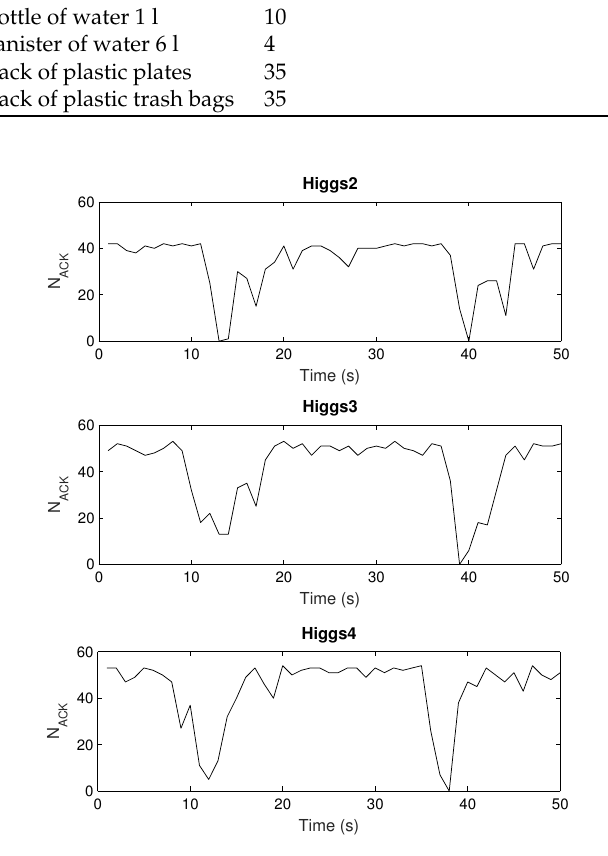
Figure 15. Sniffer measurements of tag responses when attached on cardboard.